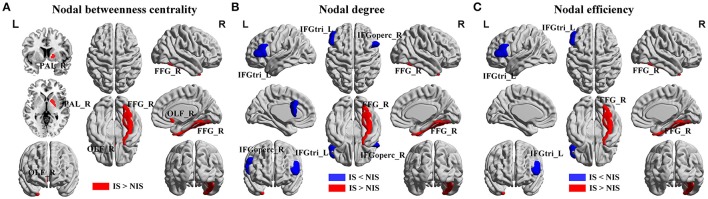
Brain regions showing altered local network properties in IS group as compared with NIS group. The aberrant (A) nodal betweenness centrality, (B) nodal degree, and (C) nodal efficiency were observed in IS group. Group comparisons were based on permutation tests (5,000 permutations, p < 0.05, controlling for the age, gender, educational level, adjusted HAMA score, and adjusted HAMD score). Colored brain areas indicate the significantly altered local network properties in IS group. The blue and red regions represent significantly decreased and increased nodal network properties in IS group as compared with NIS group, respectively. The more detailed information were presented in Table 2. IS, healthy participants with insomnia symptoms; NIS, healthy participants without insomnia symptoms; L, left; R, right; FFG, fusiform gyrus; PAL, pallidum; OLF, olfactory cortex; IFGoperc, inferior frontal gyrus pars opercularis; IFGtri, inferior frontal gyrus pars triangularis. Figures were visualized using the BrainNet Viewer software (https://www.nitrc.org/projects/bnv/).